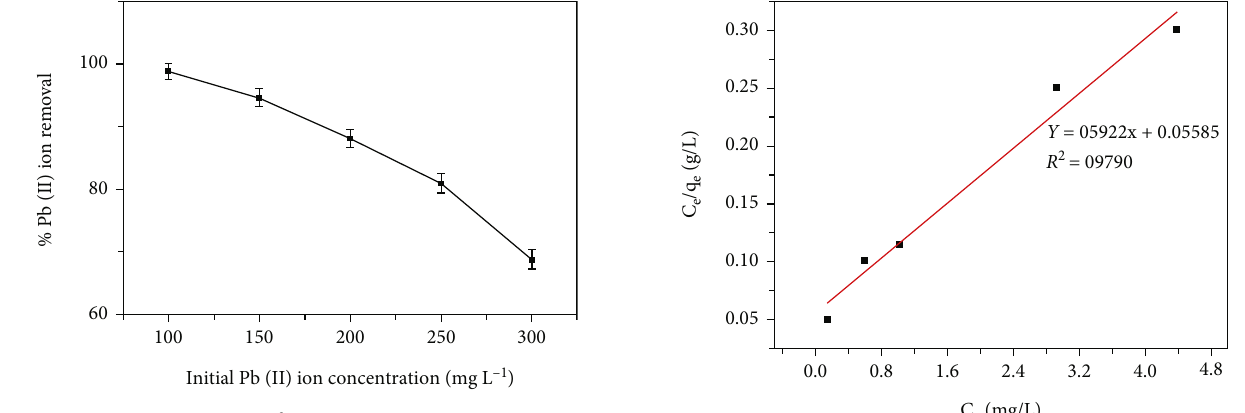
Figure 9: E ff ect of initial Pb 2+ ion concentration on adsorption behavior for agitation speed of 300rpm, temperature of 25 ° C, pH of 6, and bioadsorbent dosage of 0.5g/L contacting time of 60min.